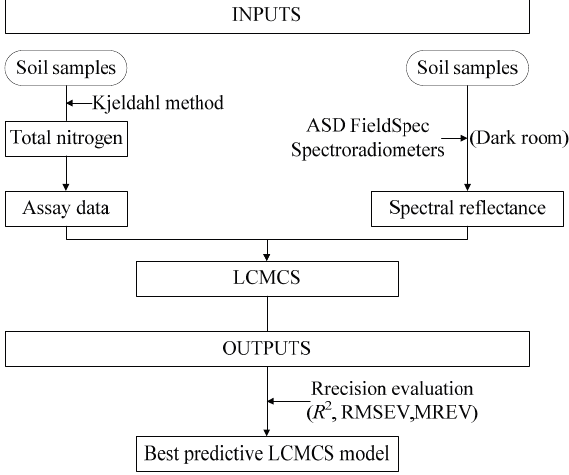
Figure 1. Schema showing an overview of the inputs and analysis steps of the work reported in this paper to produce the LCMCS prediction